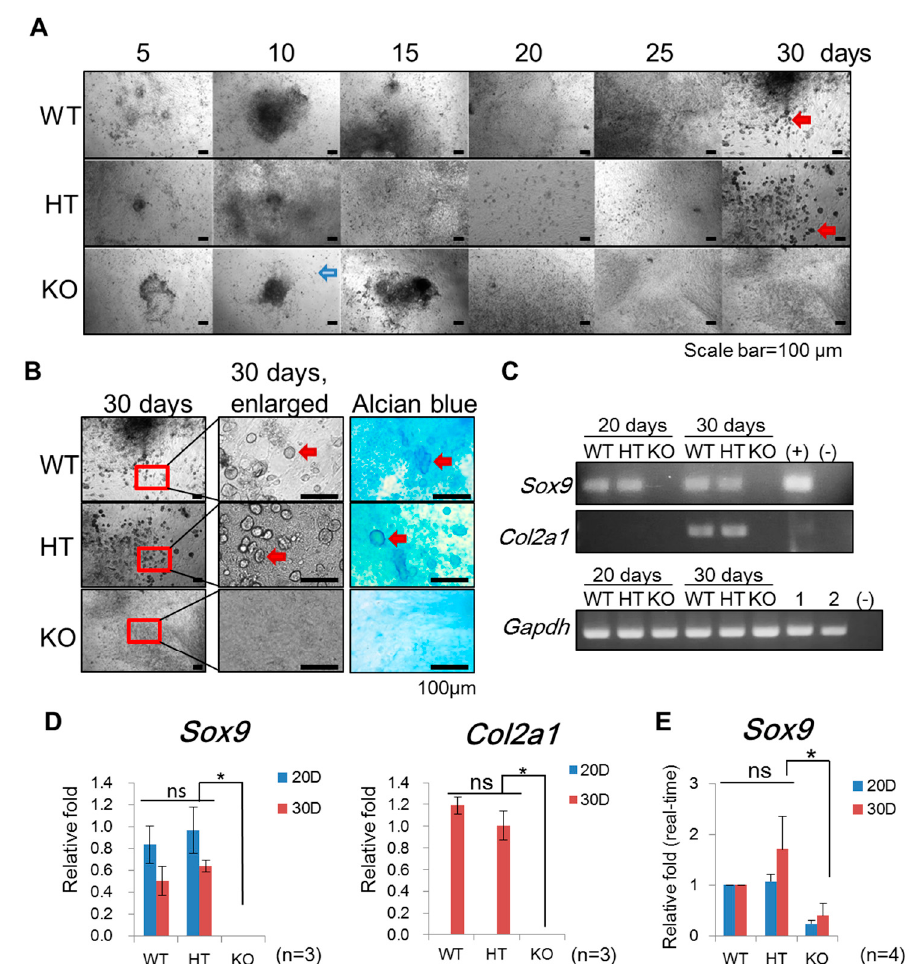
Figure 3. Terc depletion abolishes the chondrogenesis in vitro. ( A ) Morphology of chondrocyte differentiation of Terc +/+ (WT), Terc +/ − (HT), and Terc − / − (KO) ntESCs at different time point. Both Terc +/+ and Terc +/ − continues the differentiation procedure till 30 day (red arrows), but the differentiates of Terc − / − ntESCs show massive cell death around 10–15 days (blue arrow). Fewer remained cells in Terc − / − group. ( B ) After 30 days of differentiation, the cells differentiate into fibroblastic morphology and more chondrocyte-like cells with positive signal stained with Alcian Blue (red arrow indicated). ( C ) Cartilage associated genes are evaluated in differentiated ntESCs. The early cartilage marker SRY (Sex-Determining Region Y)-Box 9 ( Sox9 ) and late marker Collagen II ( Col2a1 ) expressed at 20 and 30 days of differentiation, indicating the specific induction of mesoderm-chondrocyte from ntESCs. Scale bar = 100 µ m. (+): the positive control cDNA for detecting Sox9 and Col2a1 collected from mouse testis and cartilage tissue respectively. 1 and 2 indicate the cDNA of testis and cartilage detected with internal control Gapdh primer. (-): negative control without template cDNA. ( D ) Quantification of Sox9 and Col2a1 expression level at 20 and 30 days (20D and 30D) of differentiation, calculated from the result in ( C ) for triplicate. Error bar indicates the standard deviation. Ns = no significant differences. * = p < 0.05. ( E ) Real-time PCR analysis confirms the relative expression level of Sox9 in differentiated chondrocytes. Cycle threshold (Ct) value for detecting Sox9 was normalized with Gapdh and wild-type at 20 and 30 days, respectively. Ns = no significant differences. * = p < 0.05.